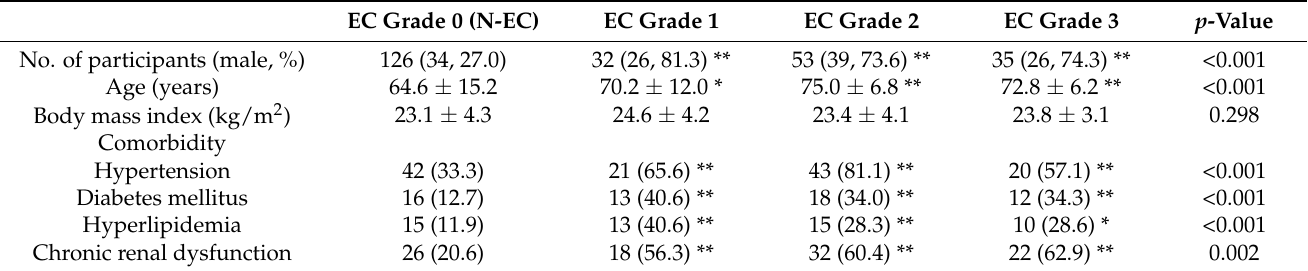
Table 4. Relationship between the grade of EC and patient